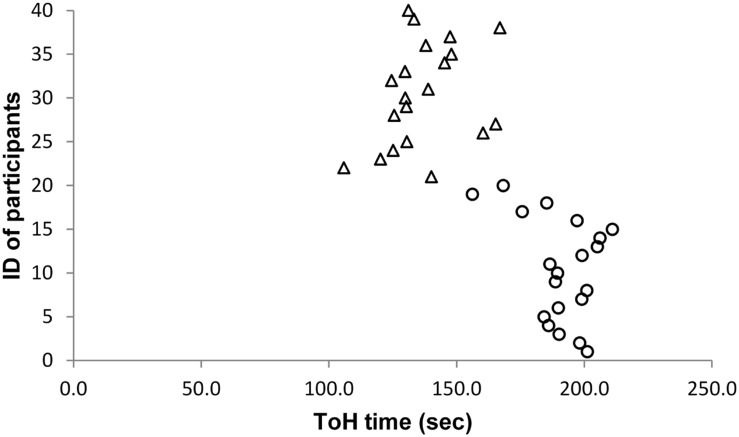
Tower of Hanoi (ToH).